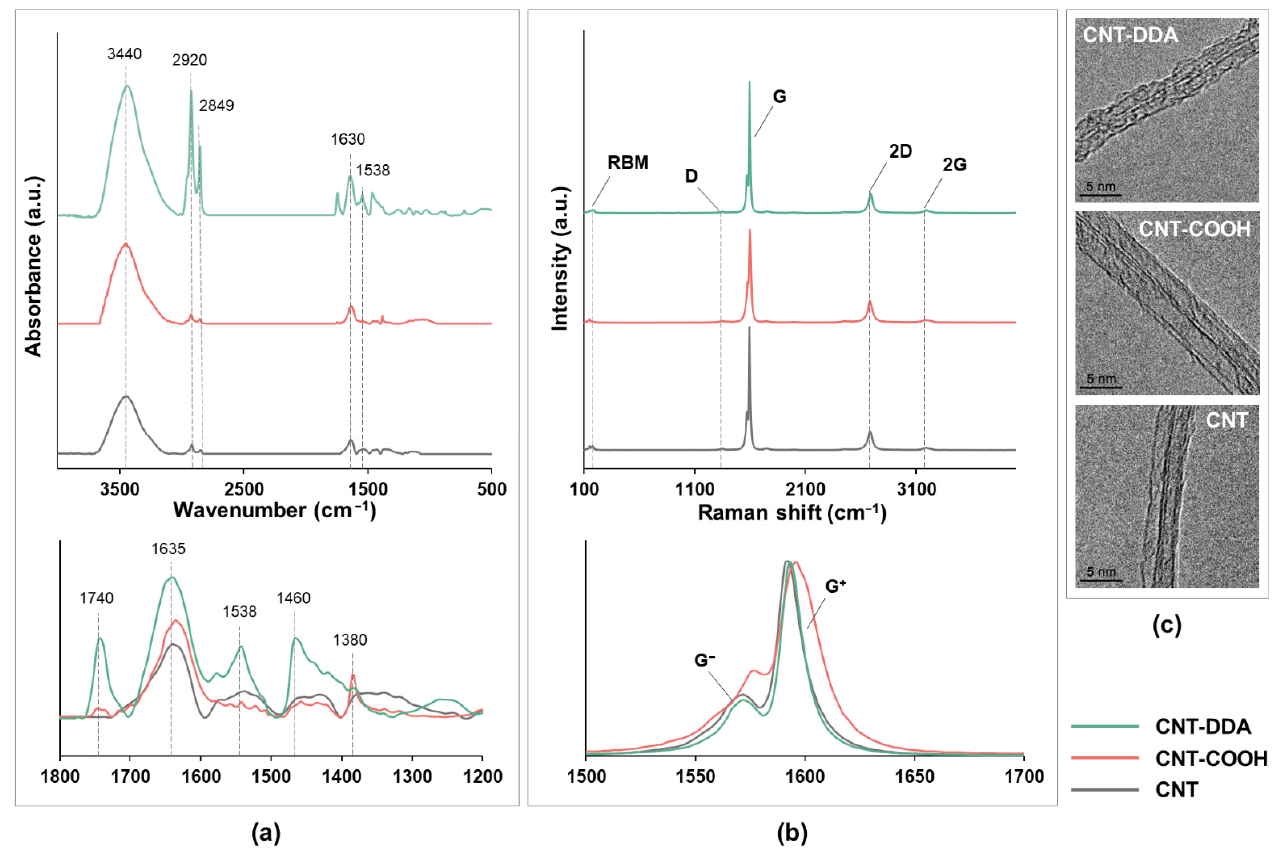
Figure 1. FTIR spectra ( a ), Raman spectra ( b ), TEM ( c ) images of unmodified carbon nanotubes (CNT), acid-modified CNT (CNT-COOH), and CNT modified with dodecylamine (CNT-DDA).